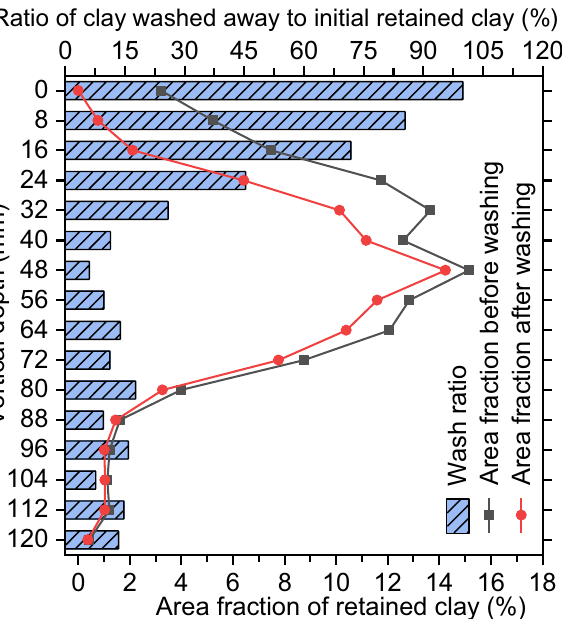
Figure 10. Vertical distributions for area fraction of retained clay before and after 30 washing cycles (line graph) and distribution of the wash ratio of clay (bar graph) for the dried clay-clogged